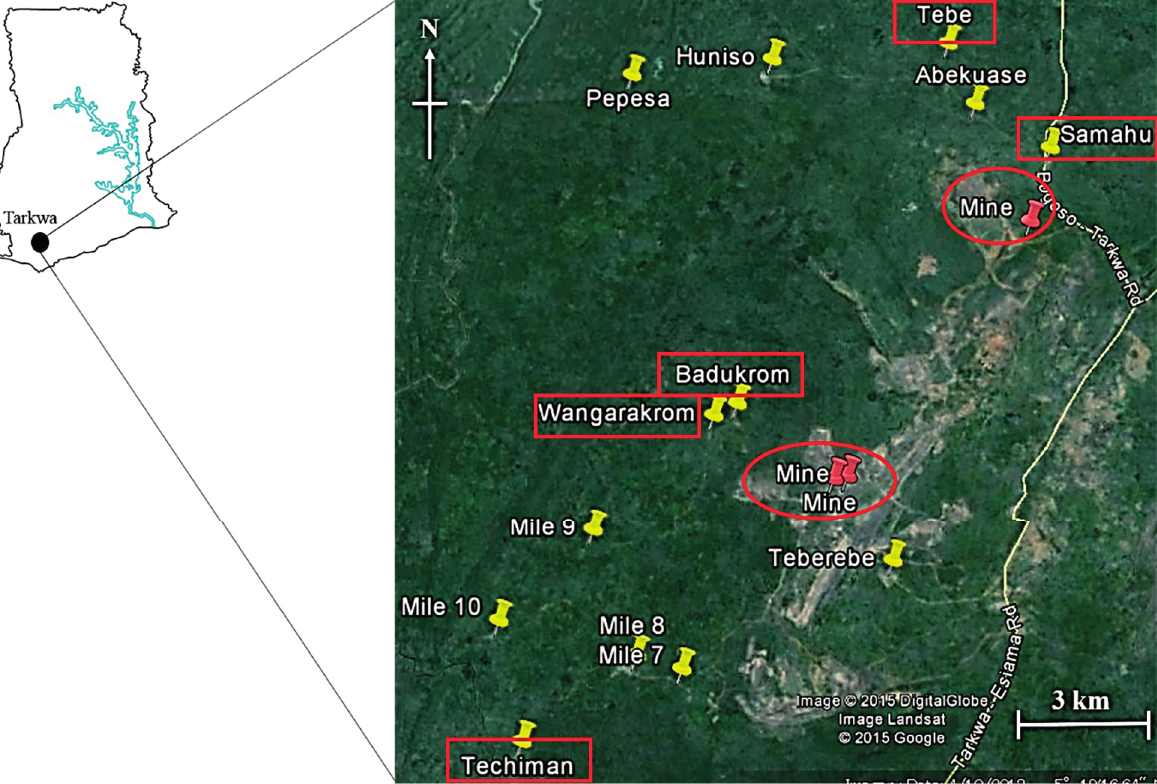
Figure 1. Map showing agricultural soils and foodstuffs sampling locations in Tarkwa (Yellow pins indicate sampled communities and red pins indicate gold